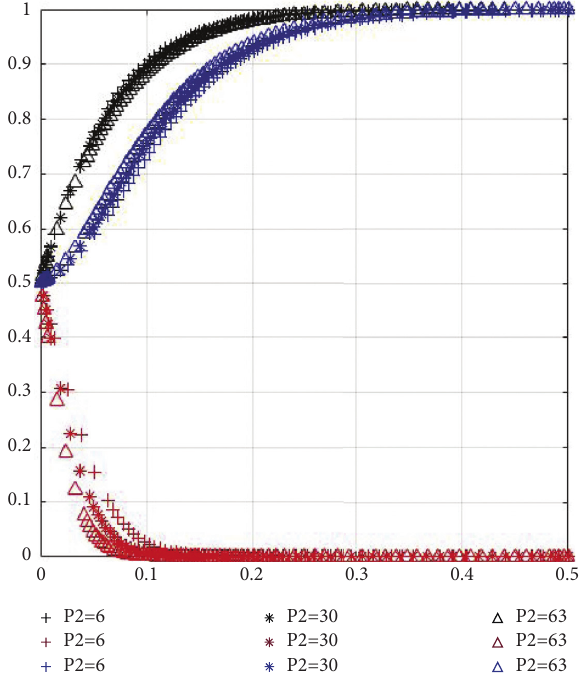
Figure 10: The revenue of We Media publishing positive infor- mation from small to large ( P 2 � 6 ⟶ P 2 � 30 ⟶ P 2 � 63).